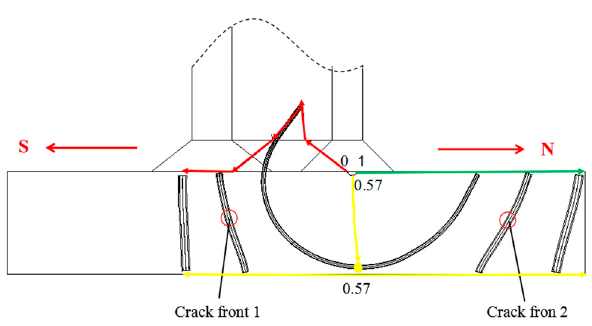
Figure 12. Evolution of characteristic points of crack front.